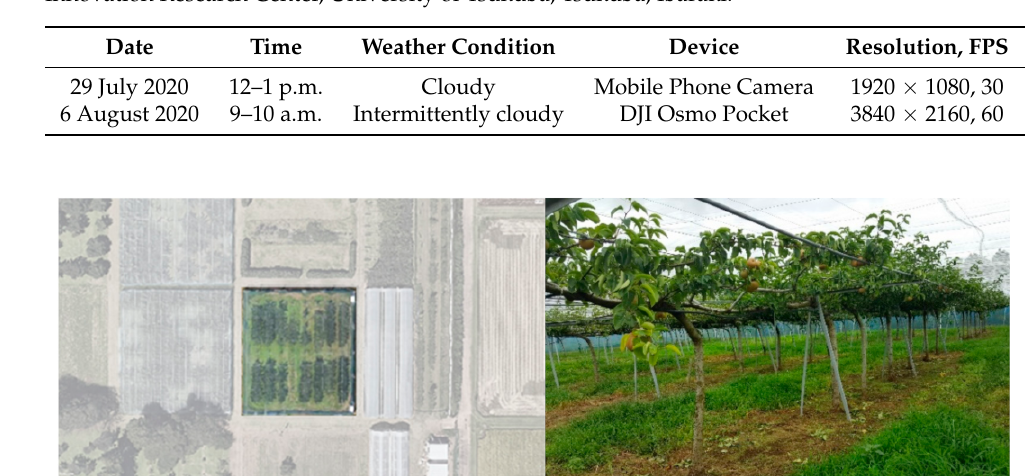
Table 1. Details of video acquisition of pear fruits in the joint-tree pear orchard in the Tsukuba-Plant